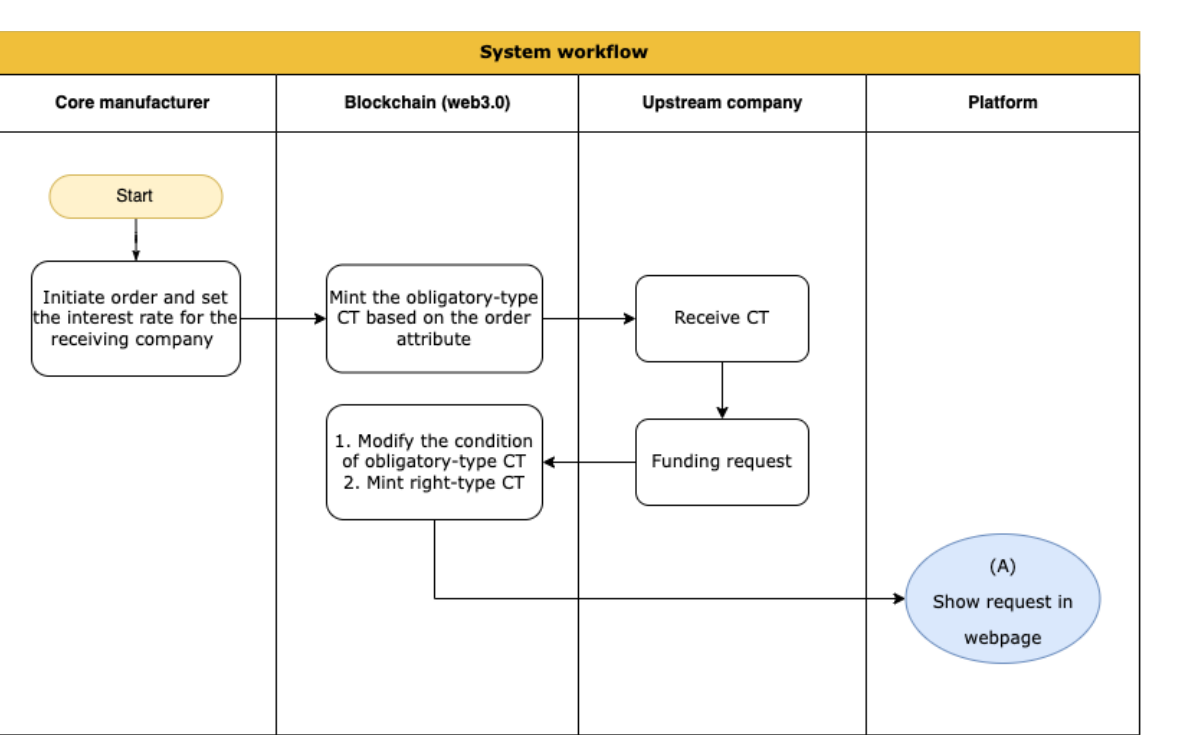
Figure 10. The workflow of channel financing, where (A) is the results shown in the webpage, and is used to list all of the funding requests. So that the funding providers can browse this list and connect to the workflow of funding as in Figure 11.